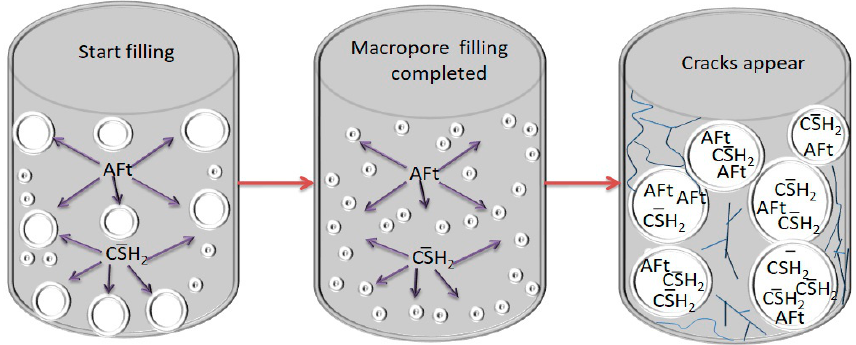
Figure 16. Expansion failure process.